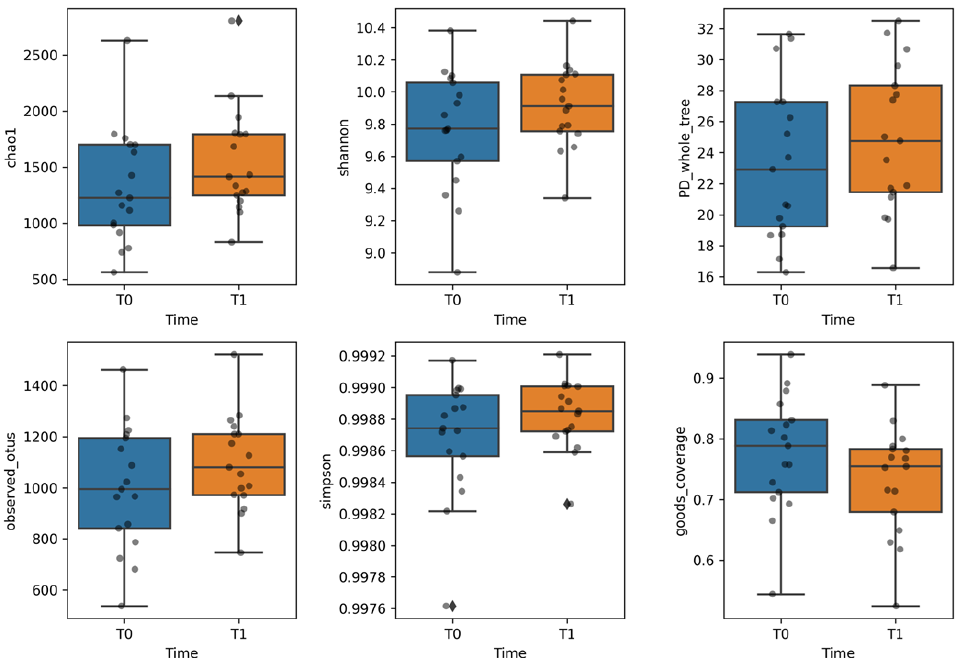
Figure 2. Evaluation of the gut microbiota ecology assessed by α-diversity of faecal sample sets at T 0 and T 1 time points, corresponding to pre- and post-probiotic supplementation, based on Chao-1, Shannon, observed species, phylogenetic distance, goods coverage and Simpson diversity metrices. No statistical significance was observed ( p value > 0.05), based on both ANOVA and Kruskal-Wallis tests. Both statistical tests were confirmed by Shapiro-Wilk and Levene’s tests, respectively. The comparison are reported at T 0 (Week 0) and T 1 (Week 8), respectively.